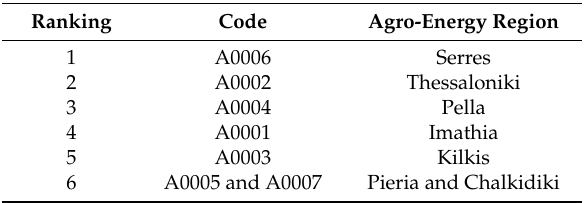
Table 7. Final ranking of the seven agro-energy regions of the